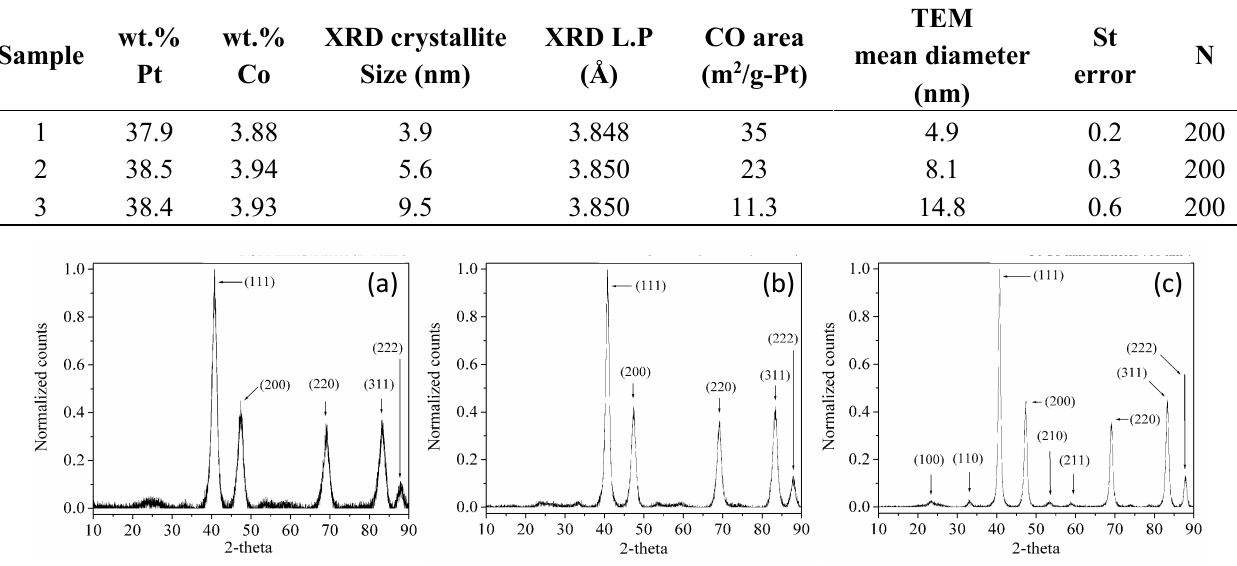
Figure 1. X-ray diffraction patterns of as prepared ( a ) 4.9 nm ( b ) 8.1 nm and ( c ) 14.8 nm Pt 3 Co on carbon